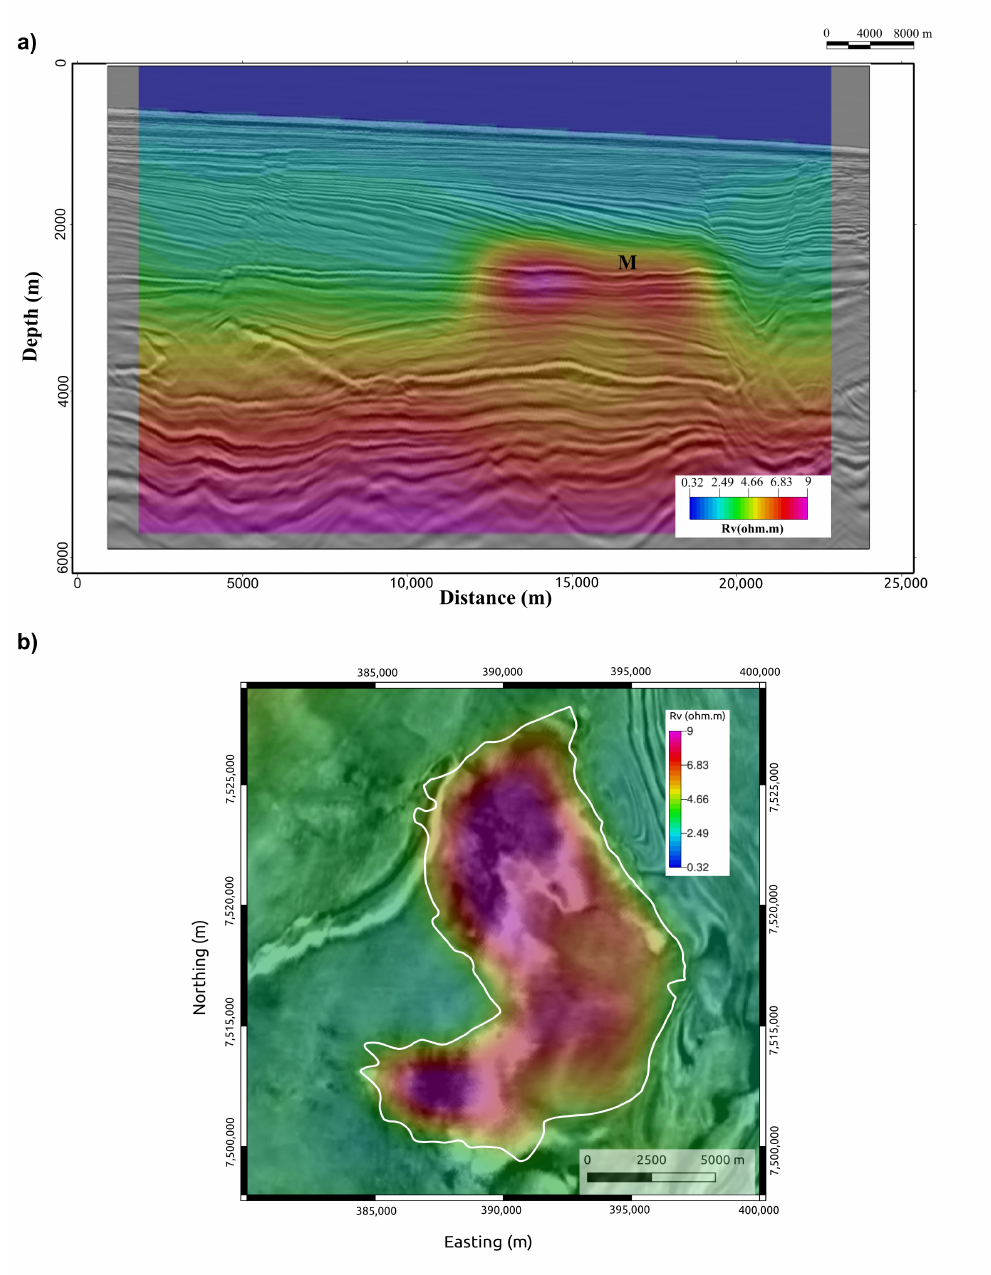
Figure 9. Rv recovered from the 2021 3D anisotropic inversion co-rendered with the seismic am- plitude of the MR3D. ( a ) Cross-section along the 04Tx13 line. The thin oil-prone turbidites in the MR3D (M) appear as anomalous seismic amplitude reflections [33]. ( b ) Recovered Rv extracted at the 2600 m depth slice. The MR3D reservoir outline is shown in the white